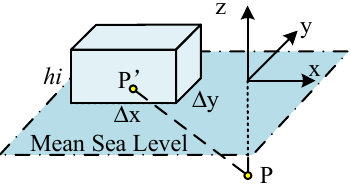
Figure 5. Right rectangular prism.